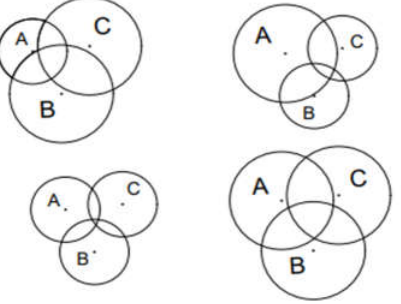
Figure 6. Nodes A, B and C intersect each other in pairs.